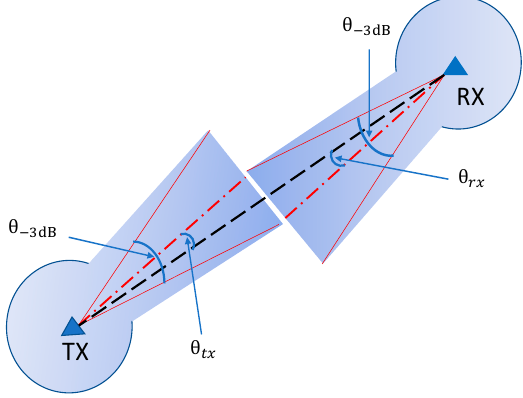
Figure 2. Schematic diagram of the mmWave flat-top antenna model.